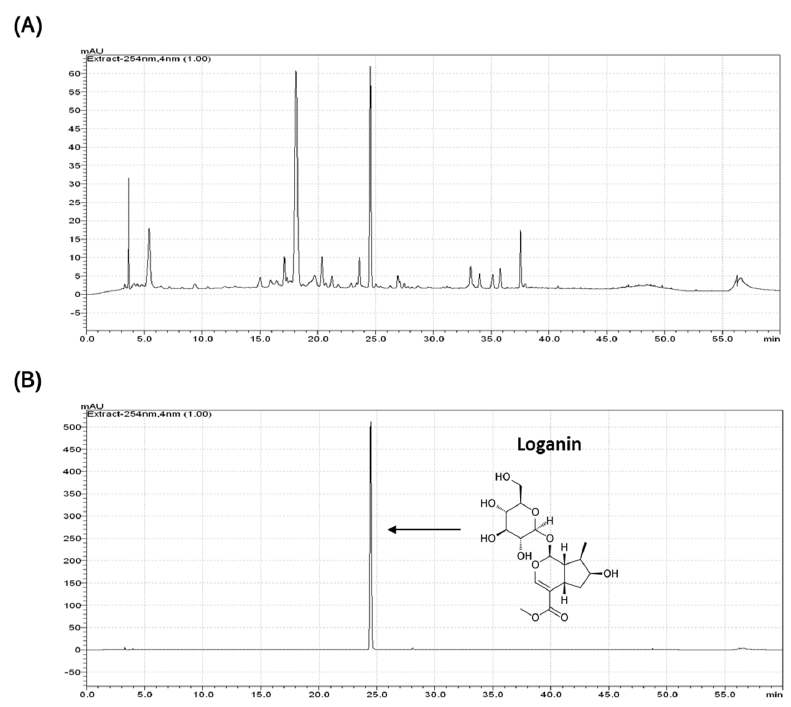
Figure 2. HPLC analysis of ( A ) total CO extract and ( B ) standard loganin compound.